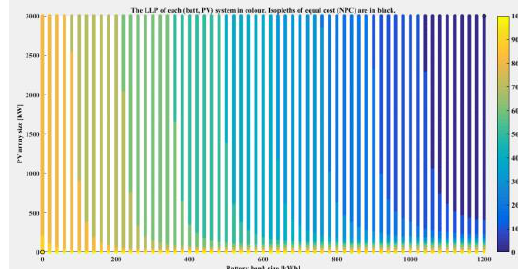
Figure 20. LLP of the system